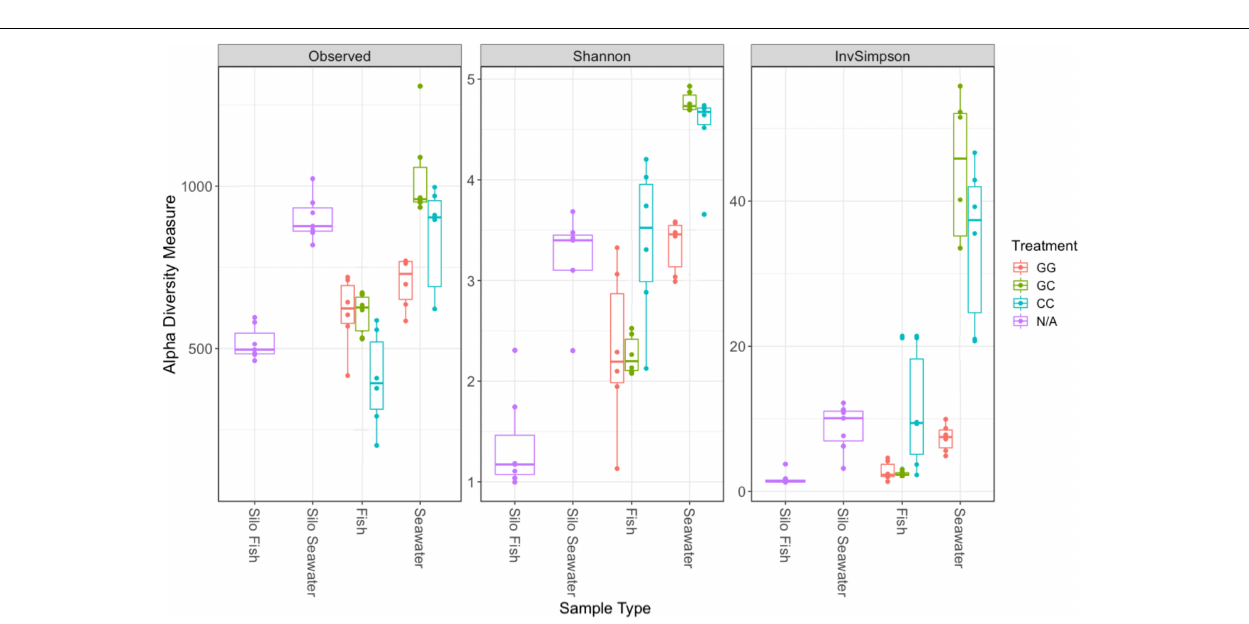
FIGURE 6 | Relative abundances of bacterial families that represent greater than 5% of the total for each sample type. Pre-experimental samples taken from sablefish hatching silos, algal paste, clay, rotifer feed, and inflowing seawater from Puget Sound.